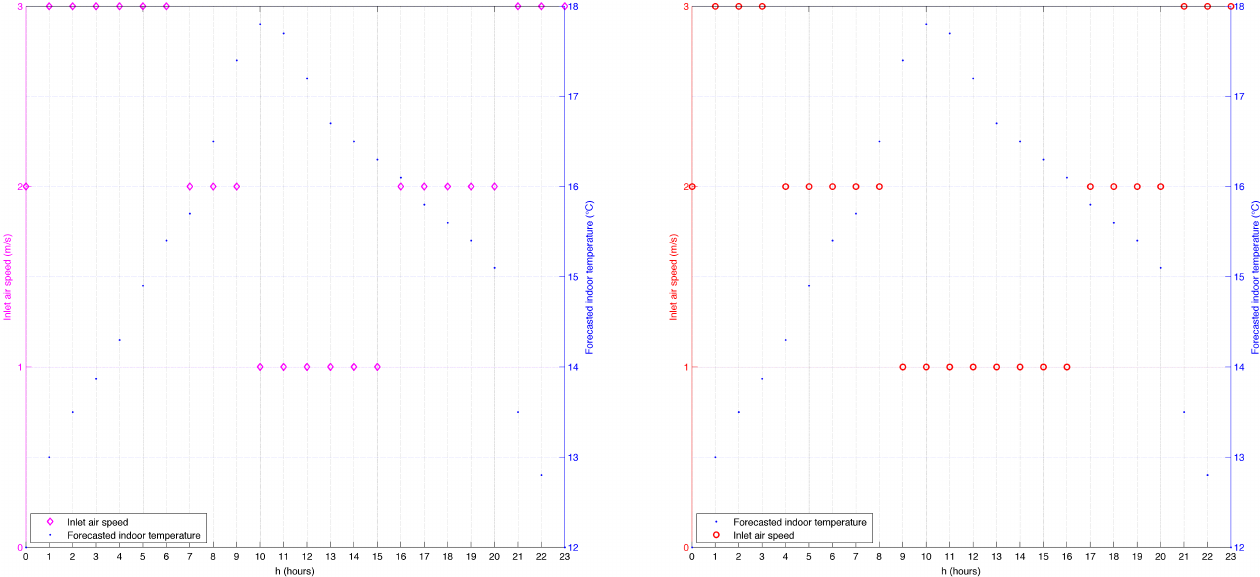
Figure 9. Winter scenario: ON/OFF speed of the HVAC system. The approach proposed in [20] (left) ; The approach proposed in this paper ( right ). Reproduced with permission from [20], Copyright 2014